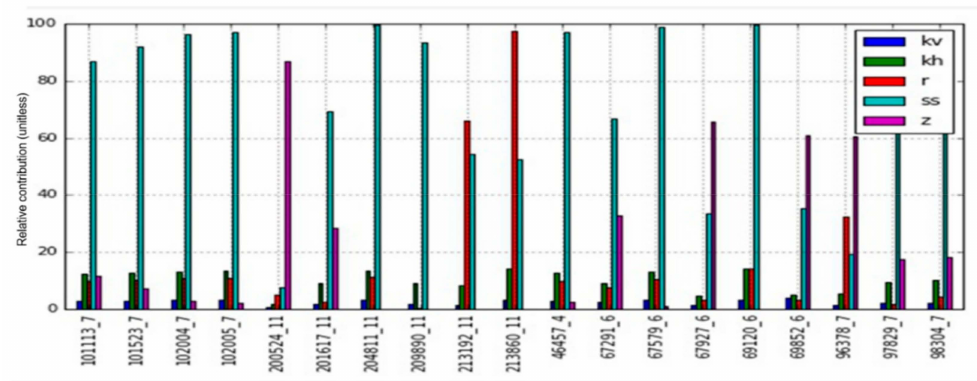
Figure 11. Relative contribution of parameter groups to prediction uncertainty in drawdown at the risk receptors (kv—vertical hydraulic conductivity; kh—horizontal hydraulic conductivity; r—recharge parameters; ss—specific storage; z—river parameters). The numbers on the x -axis before the _ correspond to the receptor numbers shown in Figure 10 and the numbers after the _ correspond to the model layer number to which the risk receptor is assigned to.